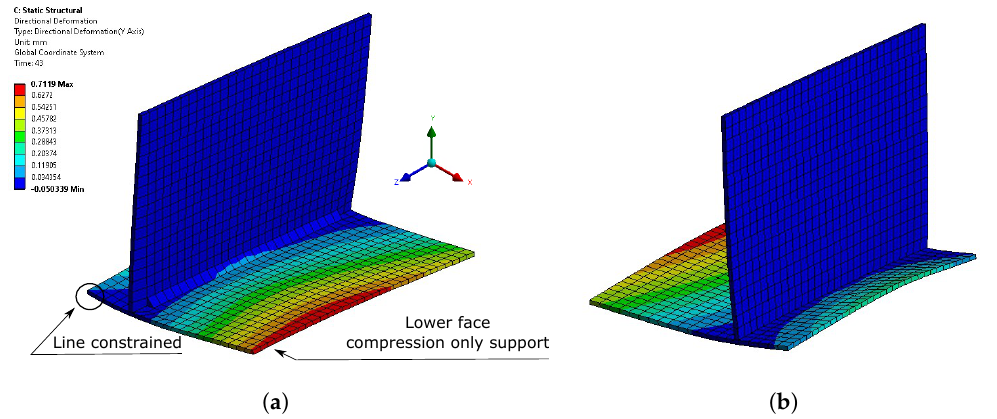
Figure 7. Boundary conditions and vertical deformation contours for the Renzi model (15 scale factors): ( a ) frontal view; ( b ) rear view.